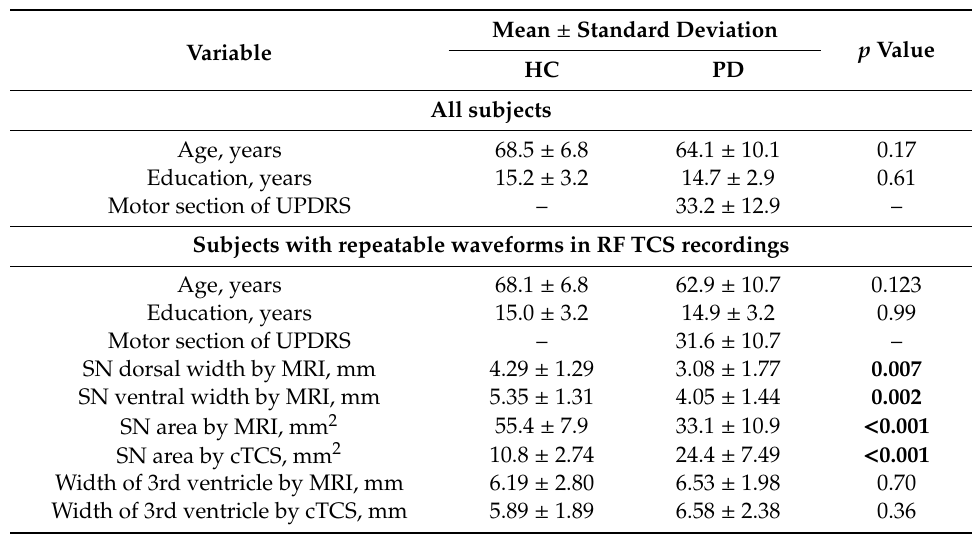
Table 1. Demographic characteristics, conventional transcranial sonography and magnetic resonance imaging quantitative measures. Statistically significant di ff erences according to the Student t test marked in